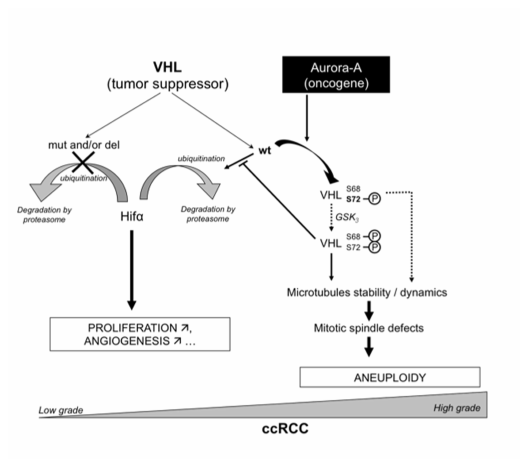
Figure 6. Putative function of the interaction between VHL and Aurora-A in the ccRCC.